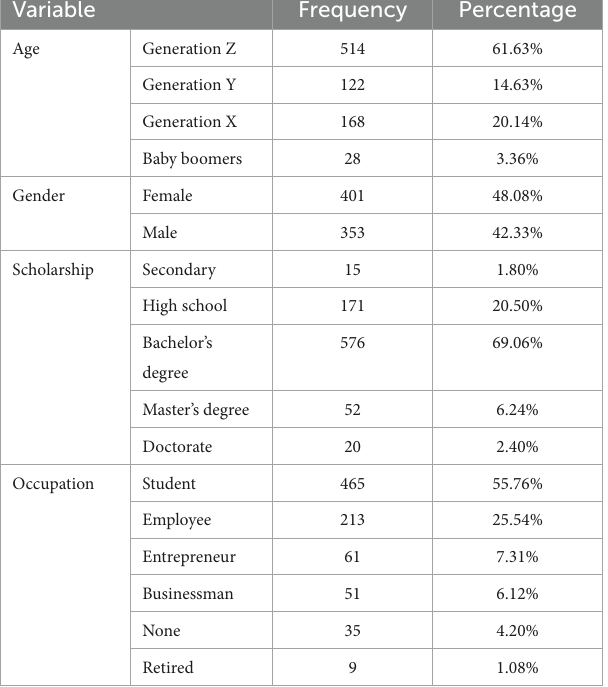
TABLE 1 Sociodemographic